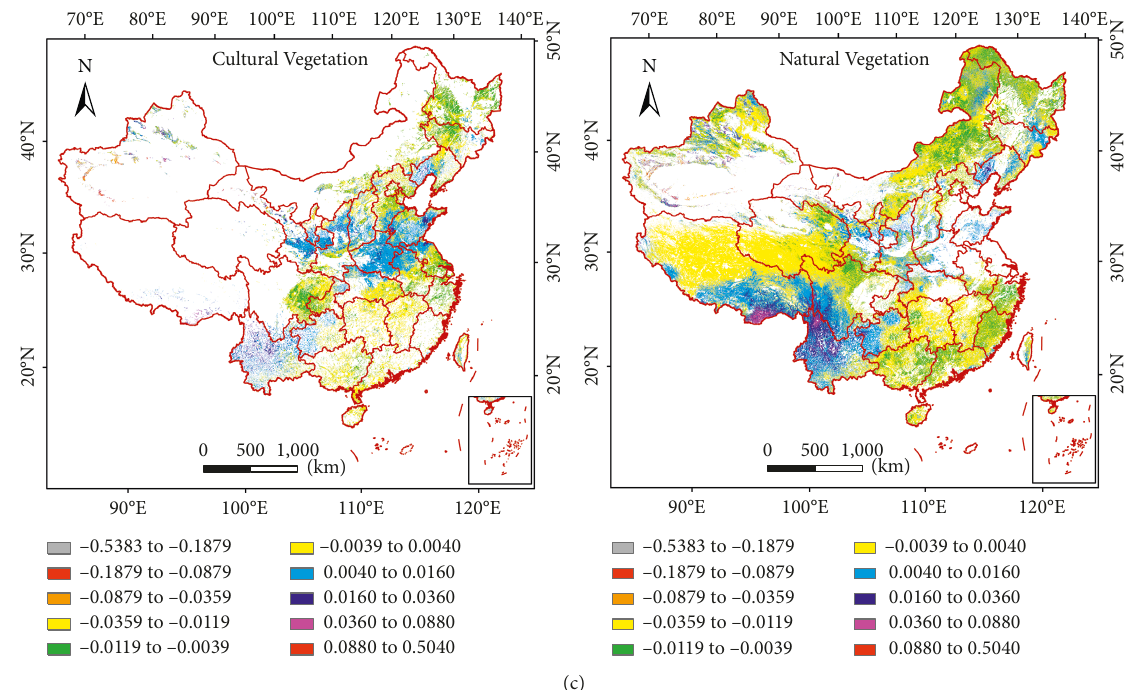
Figure 4: Temporal variation and spatial distribution of Cultural Vegetative and Natural Vegetative PUEs from 2000 to 2015. (a) Spatial distribution of the multiyear mean values of Cultural Vegetative and Natural Vegetative PUEs. (b) Standard deviations of Cultural Vegetative and Natural Vegetative PUEs. (c) Linear trends of Cultural Vegetative and Natural Vegetative